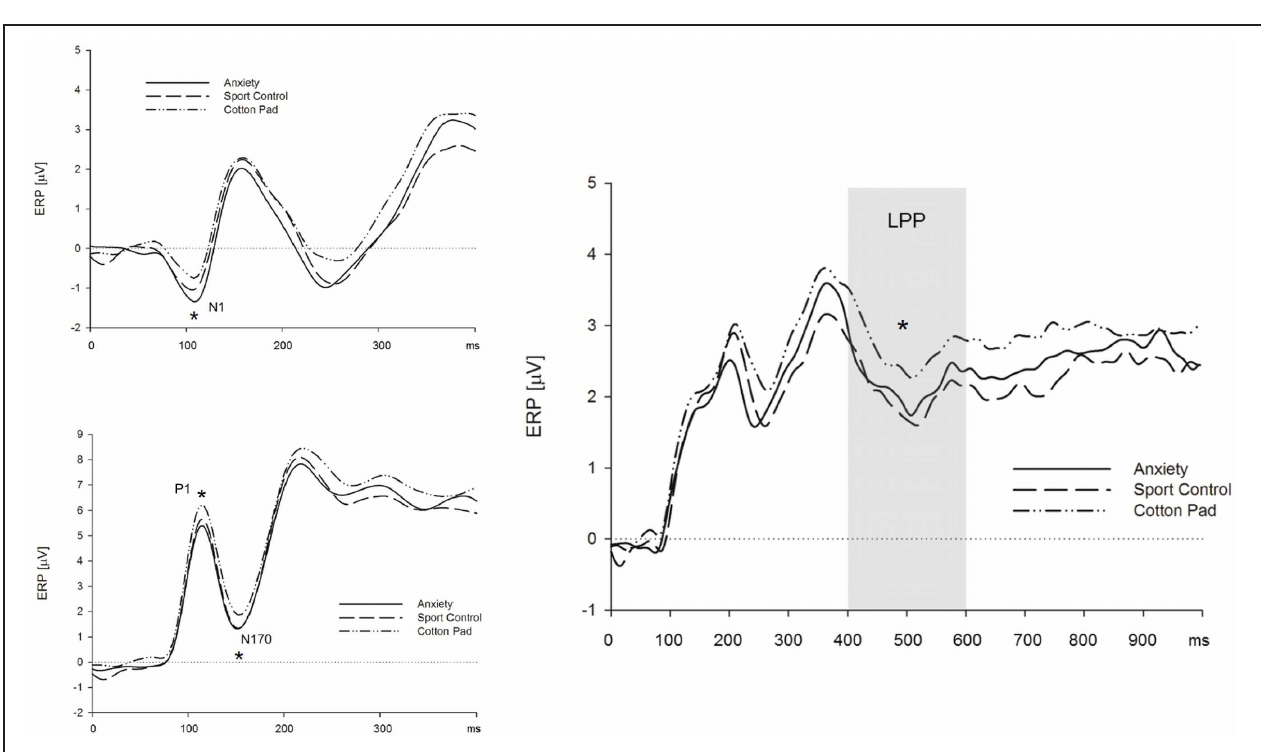
FIGURE 3 | Effects of chemosensory context on the N1 (upper left), P1 and N170 (lower left) and LPP (right) potential. Faces presented in the context of chemosensory signals elicited larger N1 and P1 potentials (central